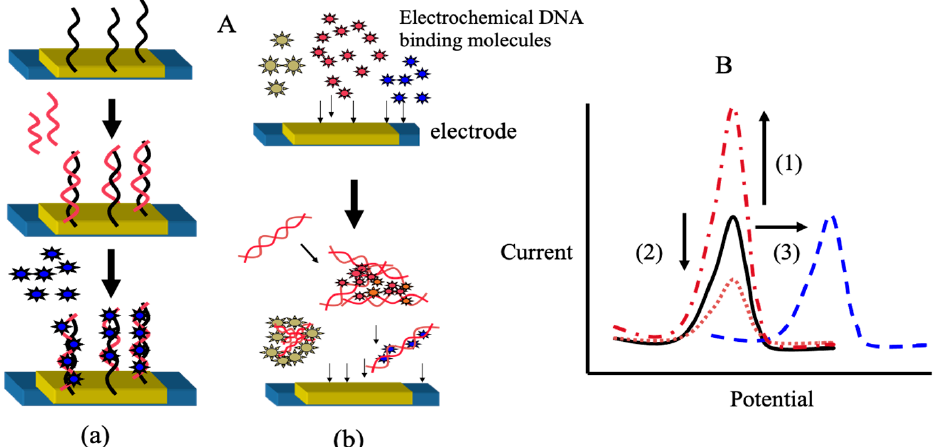
Figure 2. Electrochemical gene sensors with coupling with electrochemical DNA binding molecules ( A ): Scheme with ( a ) and without ( b ) immobilized DNA probes onto electrodes; ( B ): Type of elec- trochemical responses based on changes of current and potential. (1) Current increases with the amount of hybrid formed; (2) Current decreases with the amount of DNA; (3) Potential change with the amount of DNA.